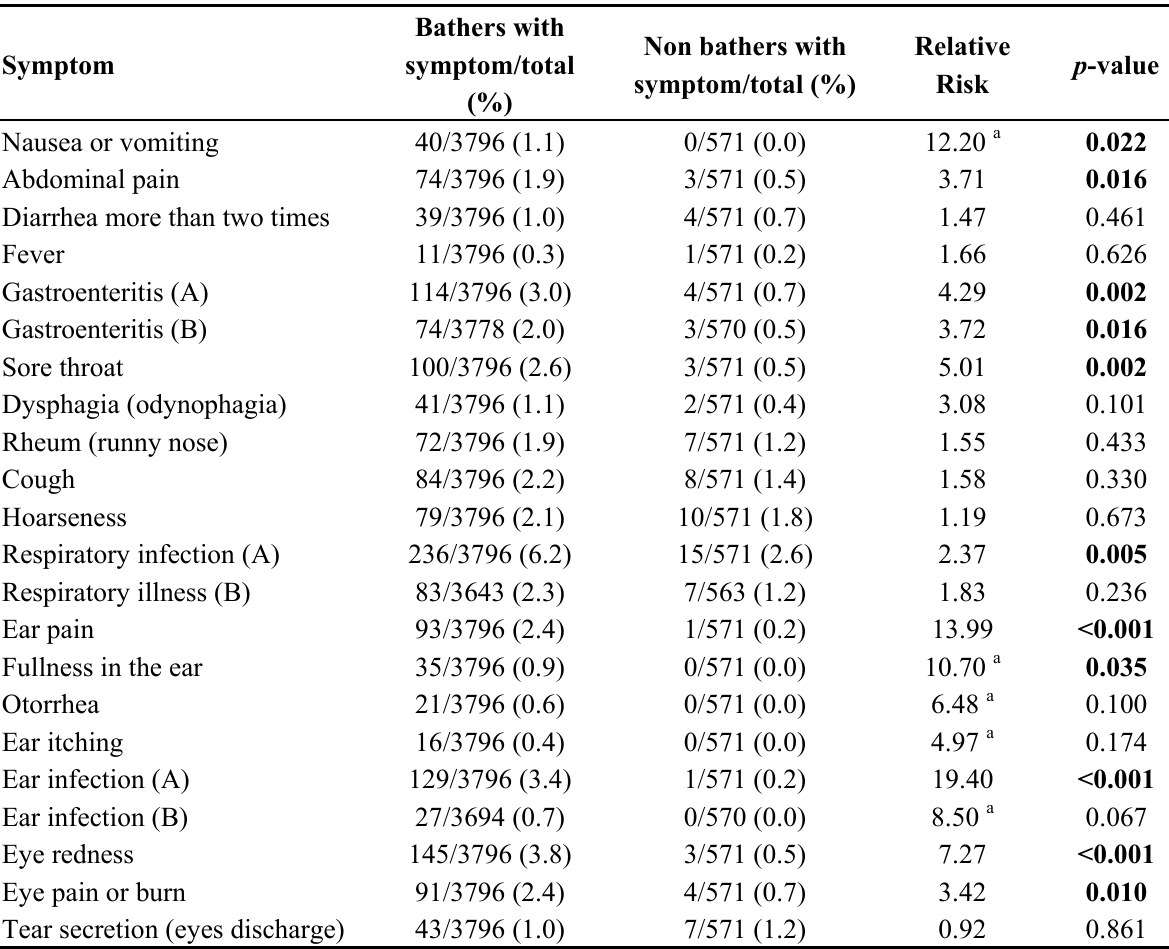
Table 3. Association of symptoms and related infections among bathers and non-bathers (univariable